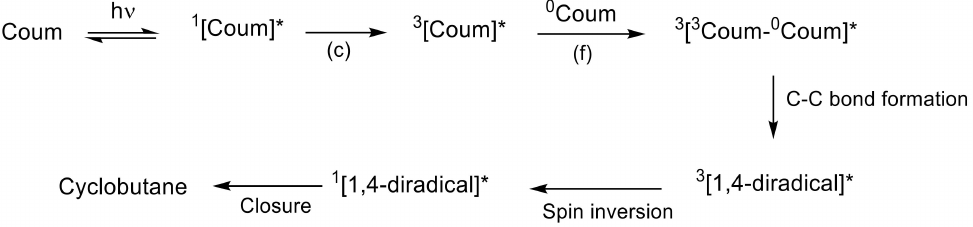
Figure 9. Possible mechanism of cyclobutane formation from [2 π s + 2 π s] photodimerization of coumarin. The asterisk (*) denotes the excited state of the